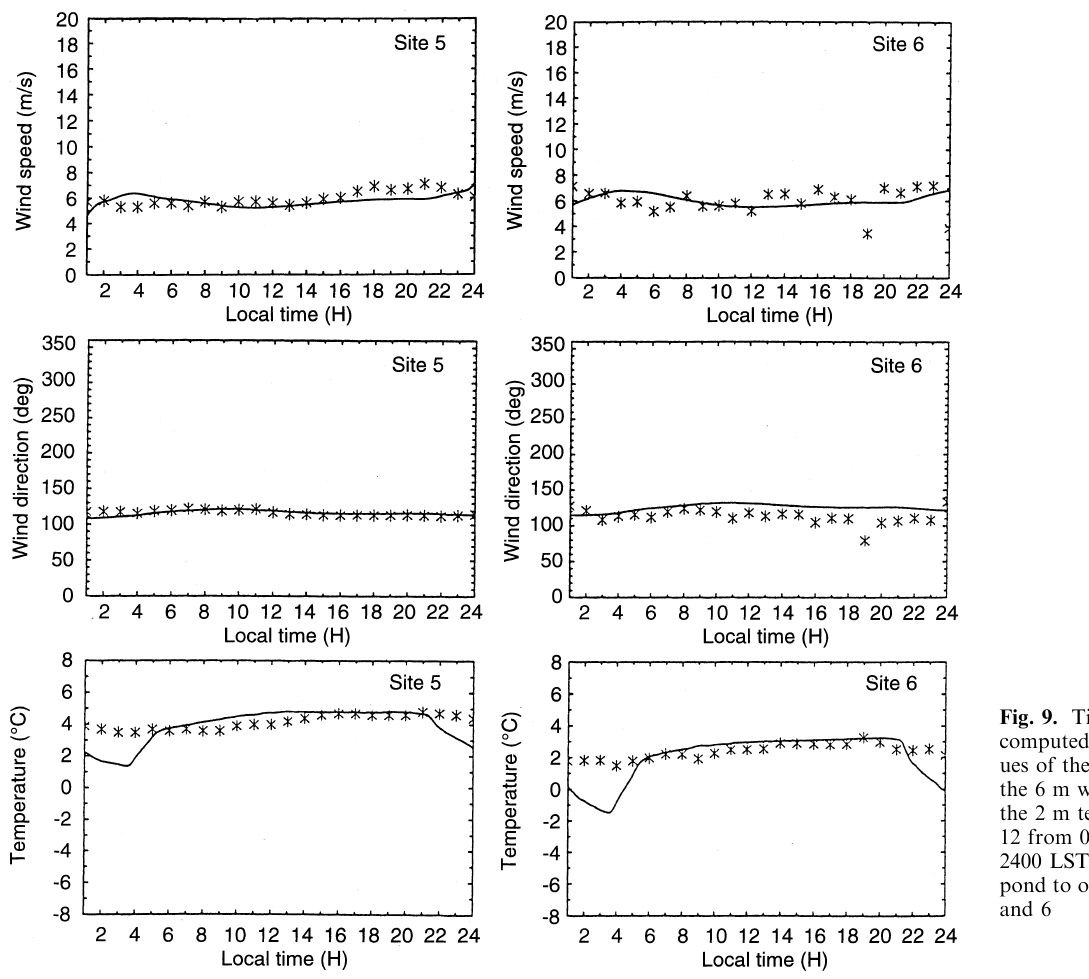
Fig. 9. Time evolution of the computed and measured val- ues of the 6 m wind speed, the 6 m wind direction, and the 2 m temperature on July 12 from 0000 LST to 2400 LST. The stars corres- pond to observations at site 5